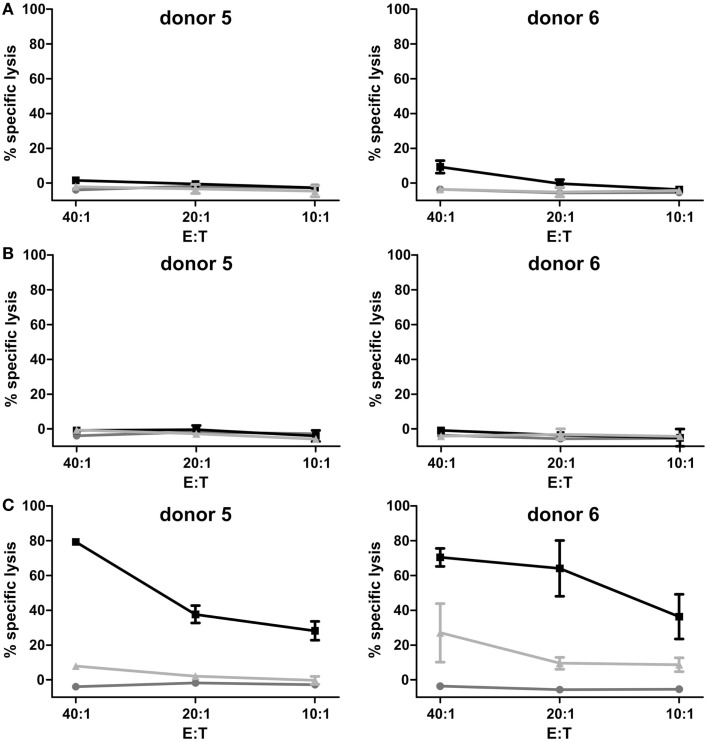
Assessment of γδ T cell-mediated AIC and ADCC in 2 h-europium-TDA release assays. Percentage of specific lysis was detected in europium-TDA release assays after co-incubation of 5000 labeled pediatric B-lineage ALL blasts per well with expanded, isolated and recovered γδ T cells at different E:T ratios (20:1–5:1) and antibodies for 2 h. The cytolytic activity after 2 h was calculated as the percentage of specific lysis [ = (experimental TDA release − spontaneous TDA release)/(maximum TDA release − spontaneous TDA release) × 100]. Two representative donors of four are shown. (A) γδ T cells (gray line), γδ T cells with 1 μg/ml control antibody (light gray line), and γδ T cells with 1 μg/ml CD19-specific Fc-optimized mAb 4G7SDIE (black line) were added, respectively. (B) γδ T cells (gray line), γδ T cells with 1 μg/ml control antibody (light gray line) and γδ T cells with 1 μg/ml CD19–CD16-bi-specific antibody construct N19-C16 (black line) were added, respectively. (C) γδ T cells (gray line), γδ T cells with 100 ng/ml control antibody (light gray line) and γδ T cells with 100 ng/ml CD19–CD3-bi-specific antibody construct N19-CU (black line) were added, respectively. Experiments were performed in triplicates. Error bars represent the standard deviation (SD).